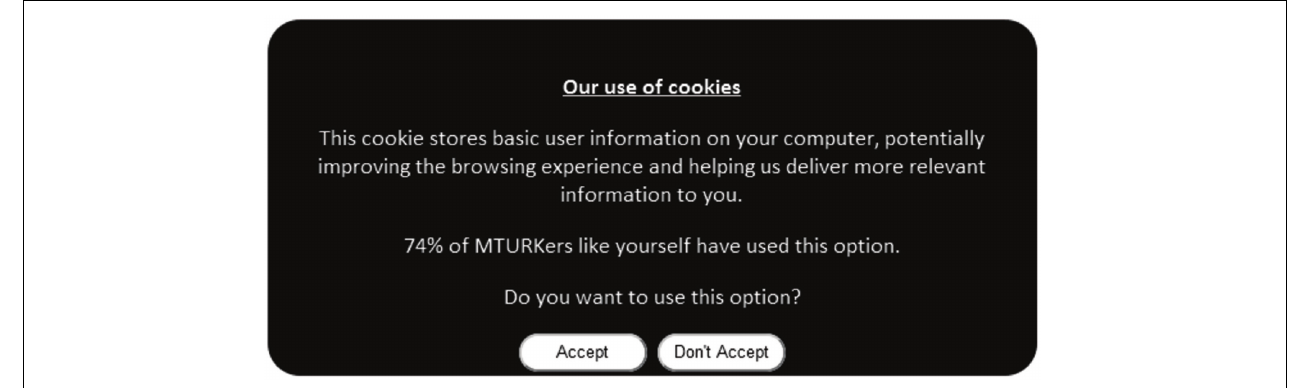
FIGURE 1 | Example of cookie dialog (displaying the majority social norm